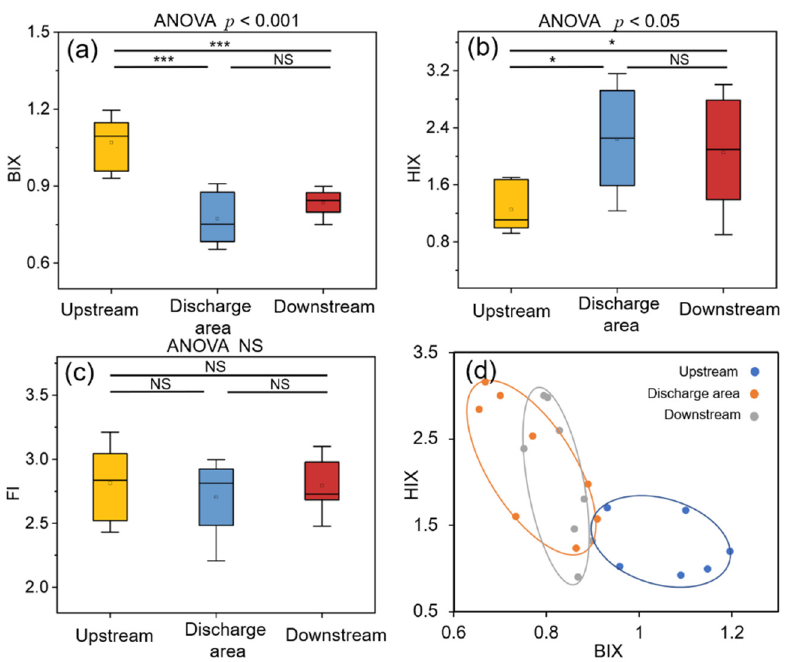
Figure 3. ( a – c ) Fluorescence parameters of biofilm water-soluble organic matter (WSOM). Asterisks represent the difference between two groups (* p < 0.05; *** p < 0.001; NS represents no significant difference) and p -values represent the overall group difference. ( d ) Values of biological index (BIX) and humification index (HIX) of biofilm WSOM in different areas: different colors represent different areas, and the horizontal and vertical coordinates indicate the values of BIX and HIX, respectively.